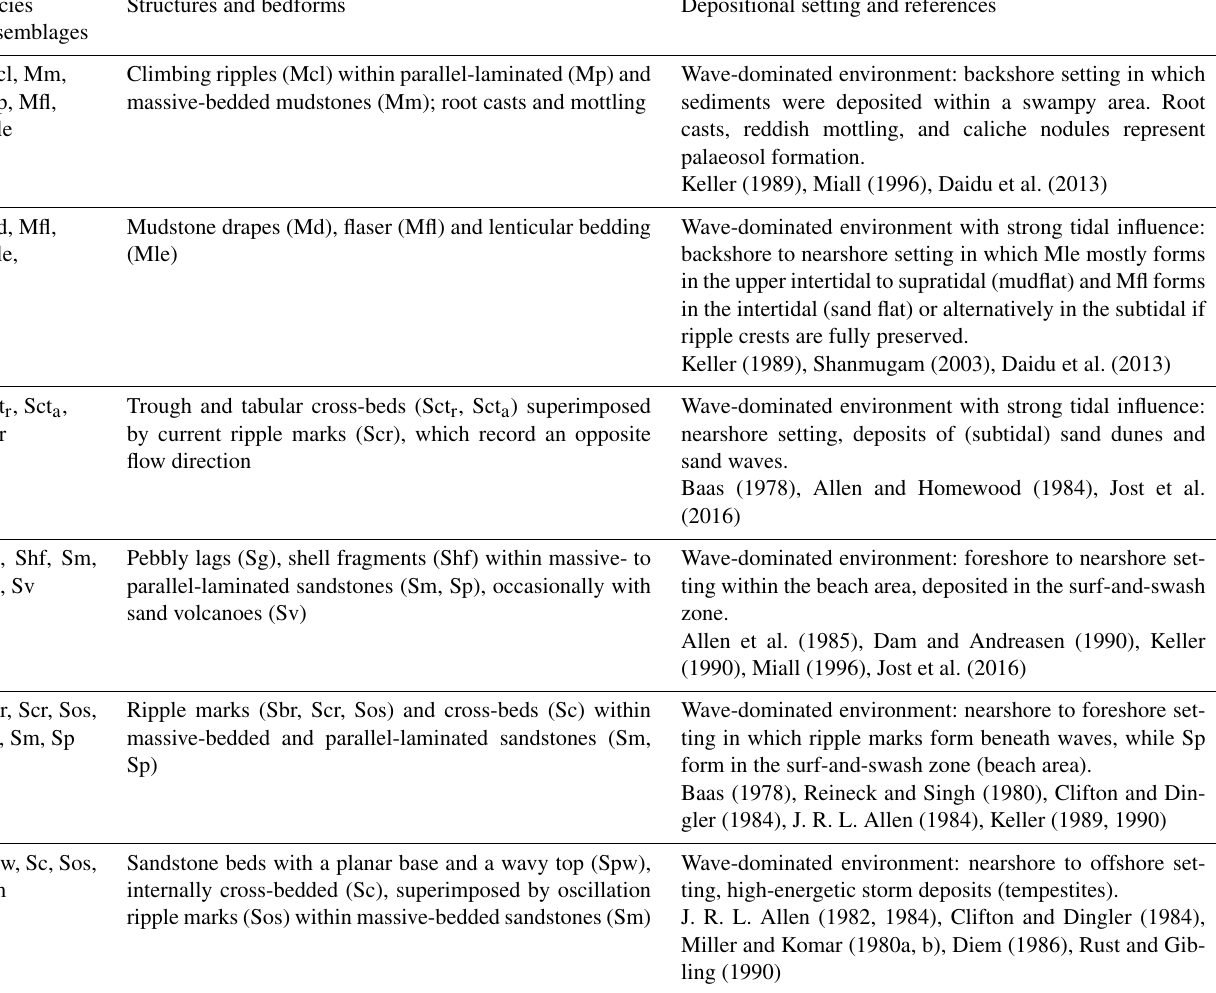
Table 1. Lithofacies encountered in the Entlen section. Facies assemblages